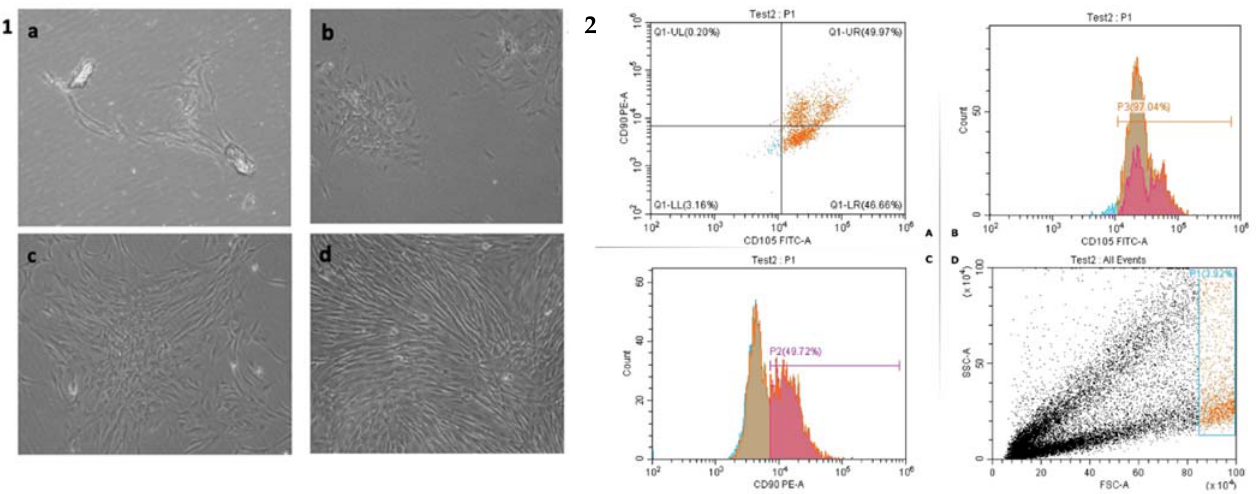
Figure 1. Photomicrograph illustrating DPSCs culture phases starting ( 1 ) from single cell attachment 3 days after isolation (a), colony formation (b), increase in colony size (c), until reaching confluence (d). ( 2 ) Phenotypic characterization of isolated DPSCs by flow cytometry showing the percentage of cells expressing CD105 and CD 90 in cells derived from pulp tissue after third passage in culture. (A) CD 105 (FITC fluorophore) versus CD 90(PE fluorophore) dot ‐ plot showing the gate of the sample used for tracing the quadrants. Events observed beyond the lower left quadrant were considered positive. (B) Gate selection by size (FSC, forward scatter) and granularity (SSC, side scatter) of the cells. (D) Histograms showing individual data of frequency of CD105, CD90 of mesenchymal stem cells (MSCs) derived from dental pulp tissue. (C).